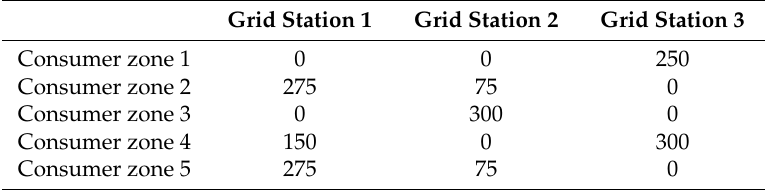
Table 9. Optimal transmission quantities from grid stations to consumer zones